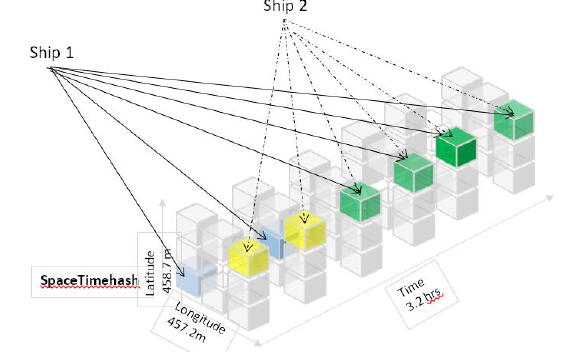
Figure 4. Illustration of the Co-Location of more than one vessel loitering for more than 3 or more time hashes and same